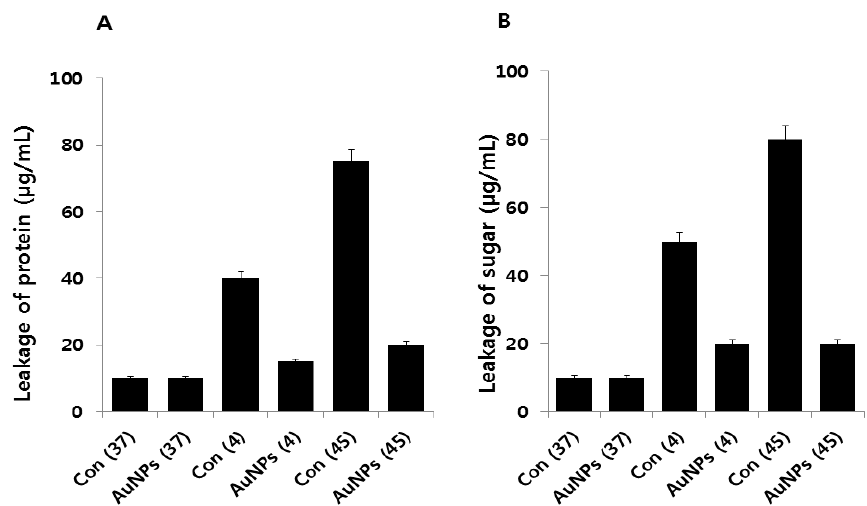
Figure 6. Effect of AuNPs on leakage of proteins and sugars. ( A ) E. coli cells were pre-incubated with AuNPs (1 μ g/mL) for 1 h, stressed at 4 °C or 45 °C, and subsequently recovered for 12 h at 37 °C. Leakage proteins were measured using the Bradford assay; ( B ) The concentrations of sugars were measured. Data are shown as means and standard deviations calculated from three independent experiments. Treated groups showed statistically significant differences from the control group by Student’s t -test ( p < 0.05).